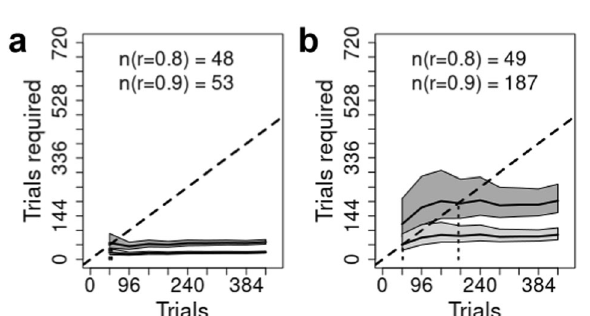
Fig. 9 | Trials required for reliable results. The total number of trials to achieve reliabilities ( r ) of 0.8 (lower line, light gray band) and 0.9 (upper line, dark gray band).Graybandsrepresenttheposteriormedian95%credibleintervals.Forevery point on the x-axis we are predicting the number of trials required to achieve a reliabilityof0.8(lightgrayregion)or0.9(darkgrayregion);thedottedverticalline descending from the dashed identity line (i.e., a line where x=y),and the values in text, provide the interpolated number of trials required for reliabilities of 0.8 and 0.9. Each panel represents a single non-gami fi ed task: ( a ) Flanker2, ( b )